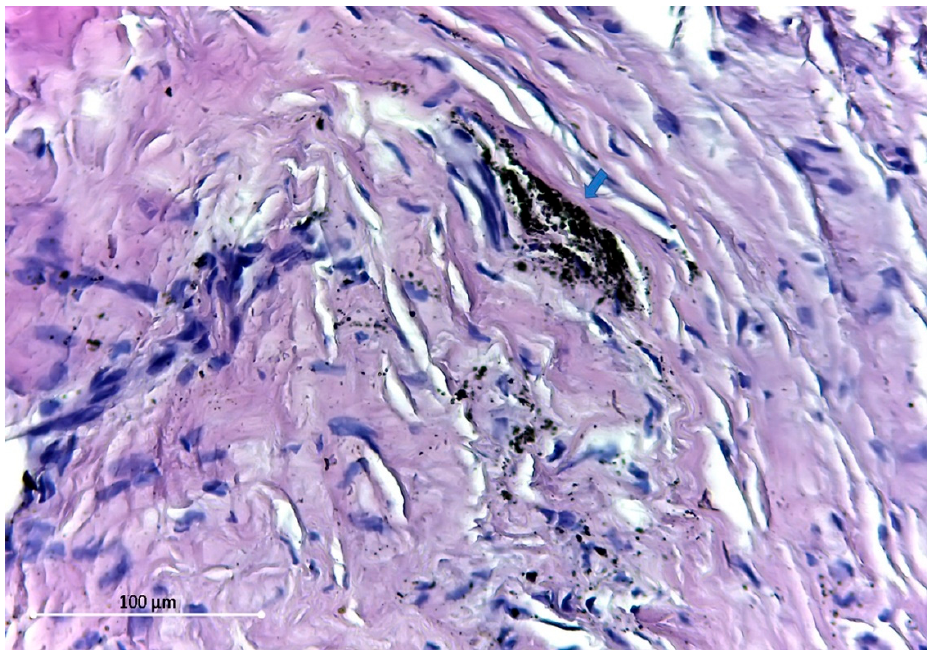
Figure 4. Dust-like (1 micron) particles—blue arrow. HE stain ×400.